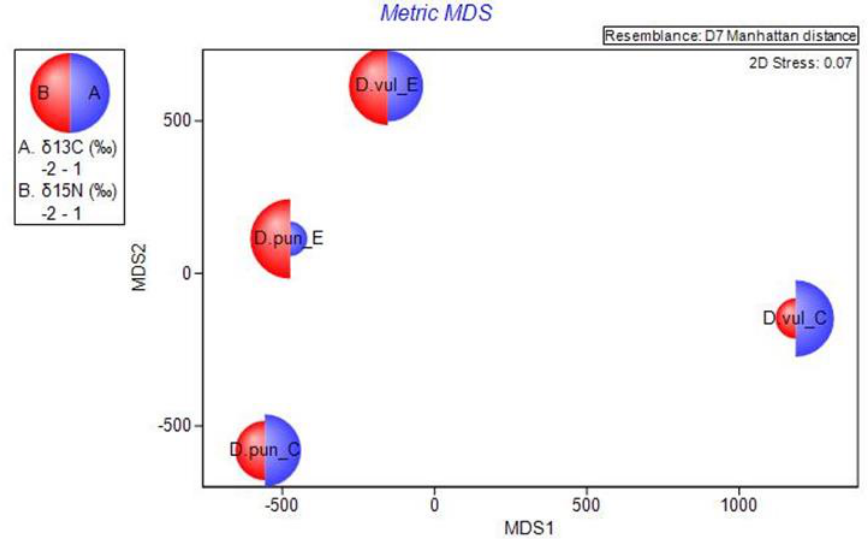
Figure 7. The metric MDS of the bivariate isotope data performed on Euclidean distances of normalized isotope values of δ 13 C and δ 15 N showing the patterns across the four groups of interest. Each half or circle correspond to δ 13 C and δ 15 N and its size reflects the contribution of each element isotope composition to the obtained distance.